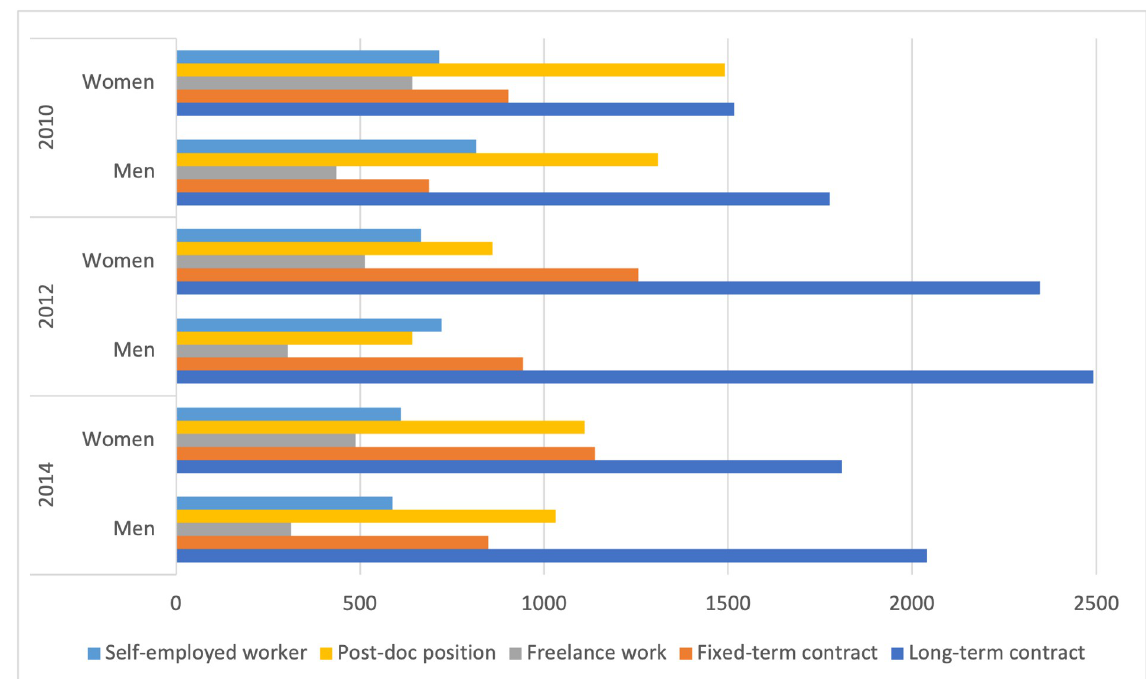
Fig 2. Ph.D. students career